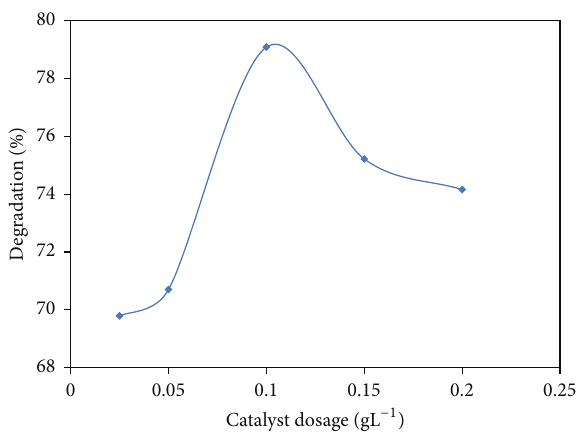
Figure 9: Effect of solution pH on degradation % (Conc.: 50 mgL −1 , catalyst dosage: 0.1 gL −1 , and intensity: 500 W).